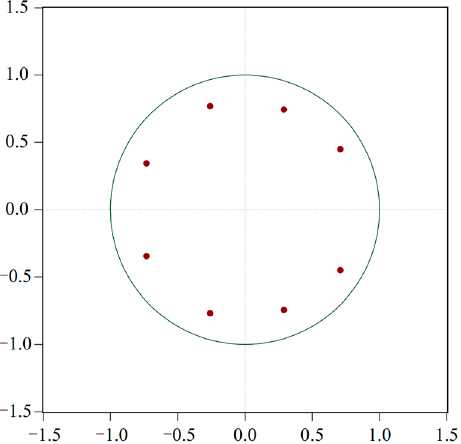
Figure 3. Discriminant diagram of VAR model stability.